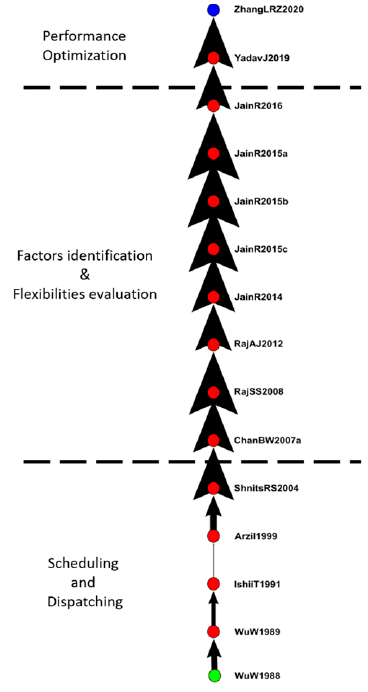
Figure 6. Global main path of decision-making facilitation through simulation.